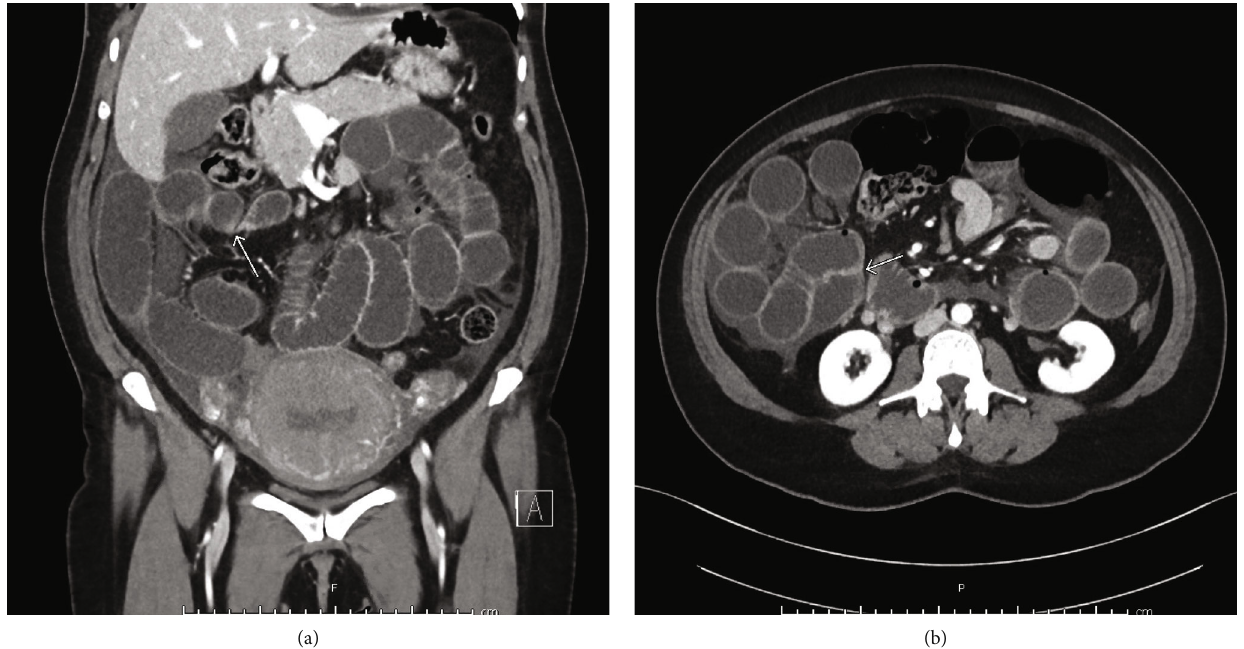
Figure 2: (a) Coronal view of CT of abdomen and pelvis with intravenous contrast showing dilated loops of bowel, closed loop small bowel obstruction with transition point (arrow) in the right mid abdomen. (b) Axial view of CT of abdomen and pelvis with intravenous contrast showing dilated loops of bowel, closed loop small bowel obstruction with transition point (arrow) in the right mid